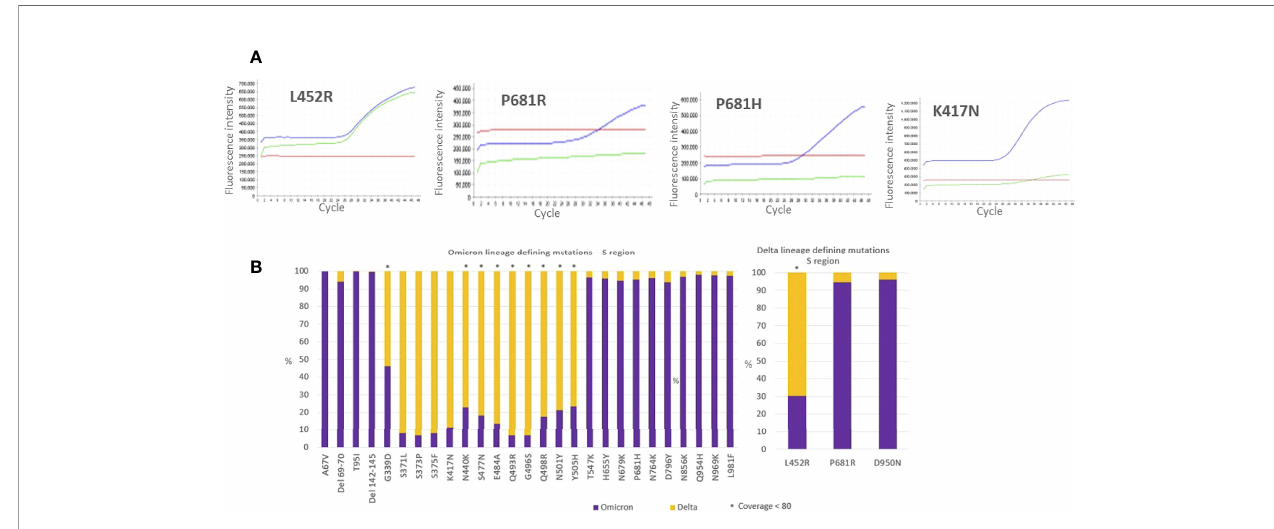
FIGURE 2 | (A) Real-time RT-PCR for VOC typing. Blue curve: presence of mutation; green curve: absence of mutation (presence of wild type); red curve: negative control. (B) Proportion of sequencing reads obtained for the S region by the whole-genome sequencing technique matching with VOCs Omicron or Delta for the analyzed mutations that de fi ne the lineage. *Positions in which the number of reads were less than